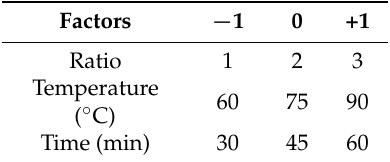
Table 1. Factors and their levels used in a Box-Benhnken design.